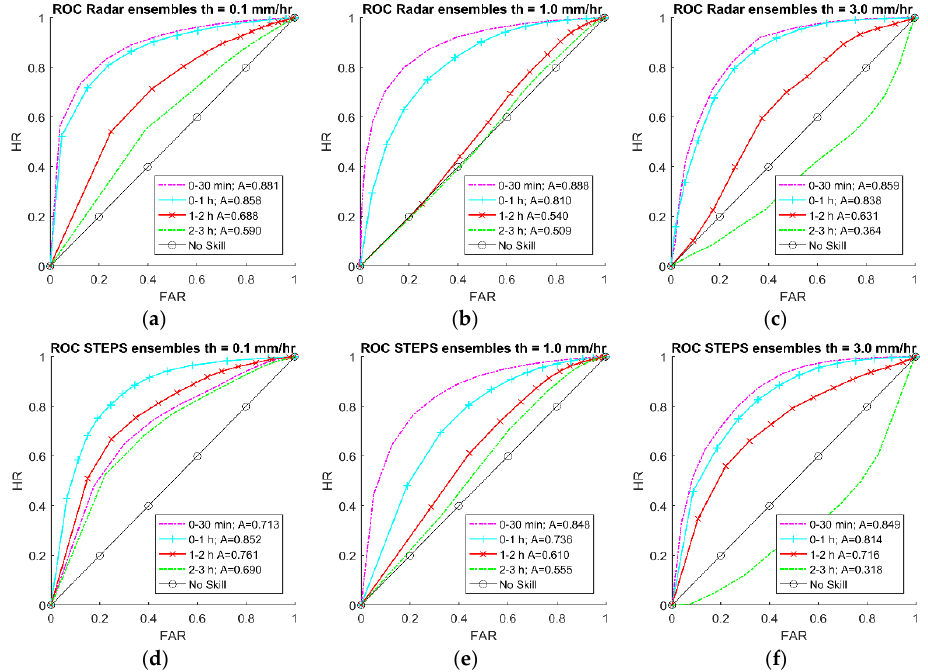
Figure 7. ROC curves for radar and STEPS ensembles for event on 14 October 2008 starting at 15:00 for Radar ensembles and rainfall thresholds (th) equal to 0.1 mm/h ( a ), 1.0 mm/h ( b ) and 3.0 mm/h ( c ). and STEPS ensembles and thresholds equal to 0.1 mm/h ( d ), 1.0 mm/h ( e ) and 3.0 mm/h ( f ).